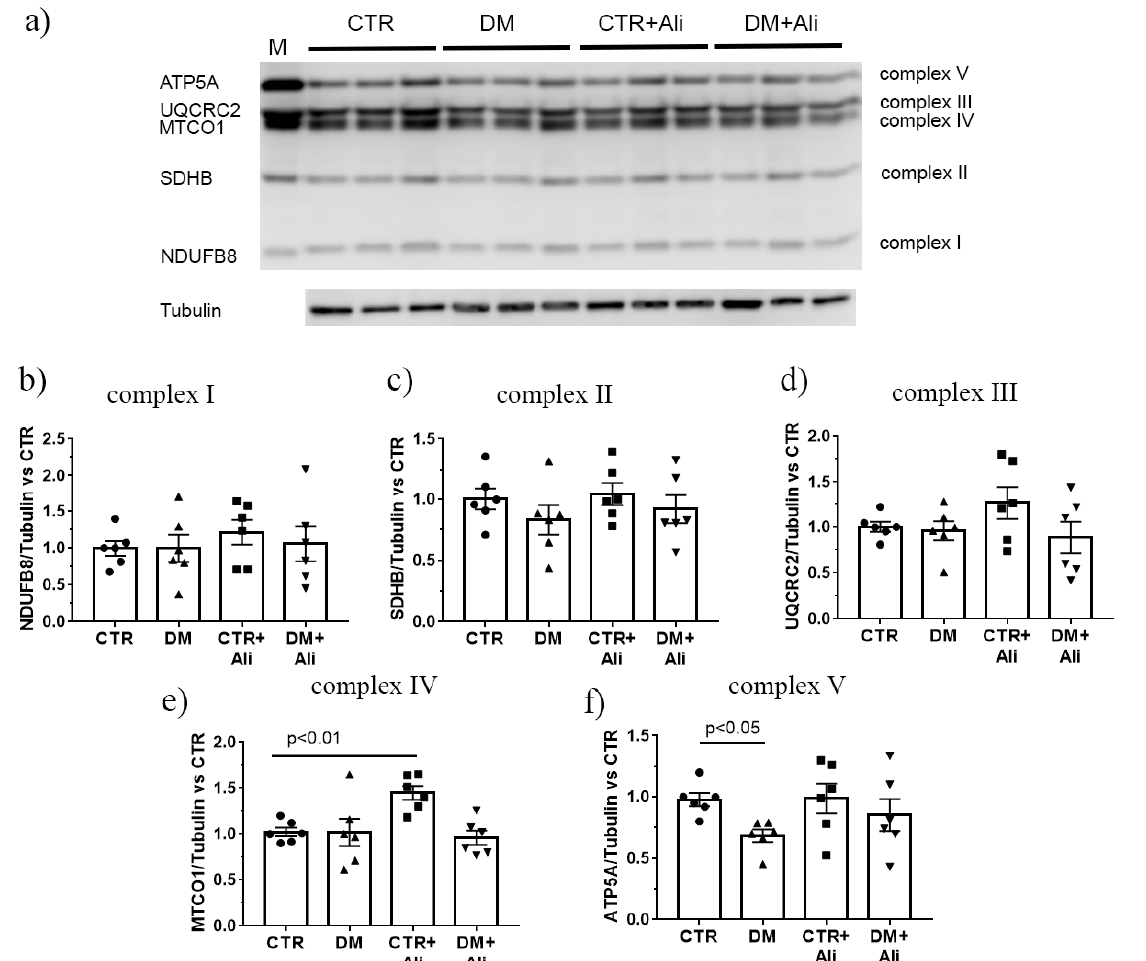
Figure 4. Levels of the proteins of mitochondrial respiratory chain complexes. ( a ) Data from the Western blot analysis. The letter of “M” indicates a positive control (rat heart tissue lysate—mitochondrial extract). Quantification of complex I/tubulin ratio ( b ), complex II/tubulin ratio ( c ), complex III/tubulin ratio ( d ), complex IV/tubulin ratio ( e ), and complex V/tubulin ratio (ATP synthase, f ). The data are presented as mean ± SEM ( n = 6).